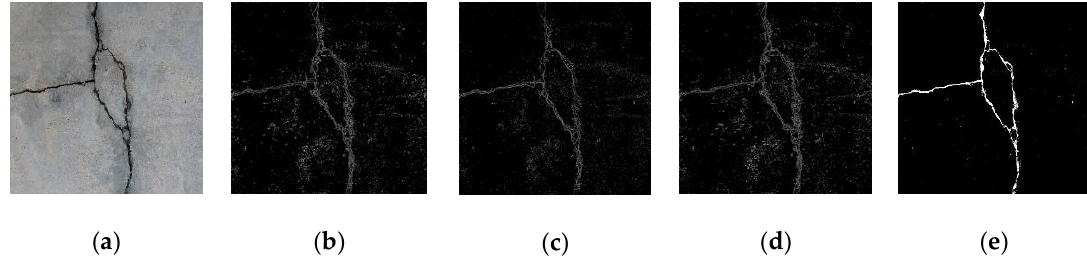
Figure 16. Comparison between edge detection and MLP, subject to ( a ) no treatment; ( b ) Prewitt operator; ( c ) Roberts operator; ( d ) Sobel operator and ( e ) MLP proposed in this study.